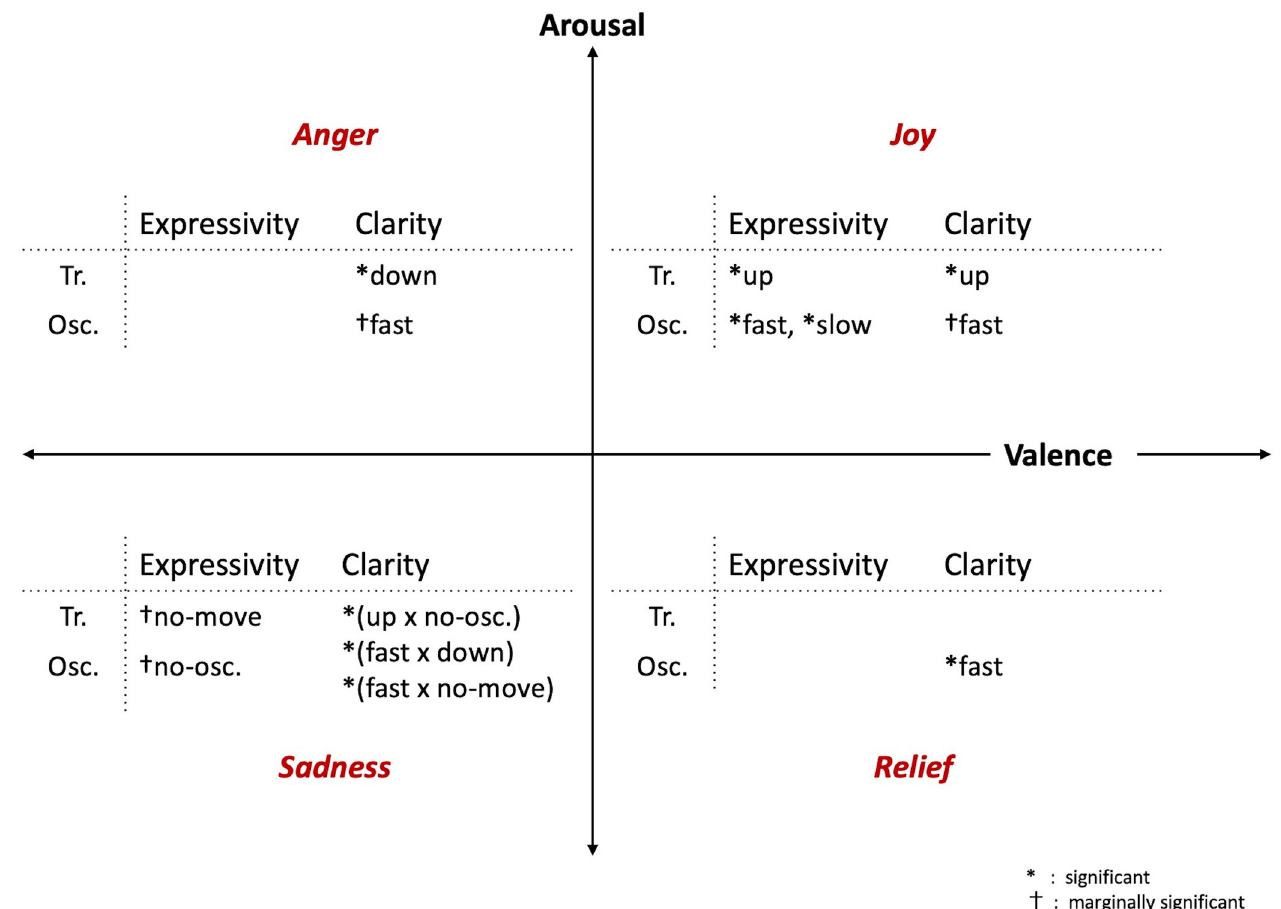
Fig 9. Effective movements for different emotions in short-term expressions. Summary of the effective vertical movements on improvements of expressivity and clarity for short-term emotion expressions of the robot. The vertical transition and oscillation of the robot is denoted with Tr . and Osc . in the figure, respectively. Note that in the figure, if a movement such as A was effective under the condition B, it is noted as (B × A). Also, the notation no-osc . indicates the no-oscillation condition.